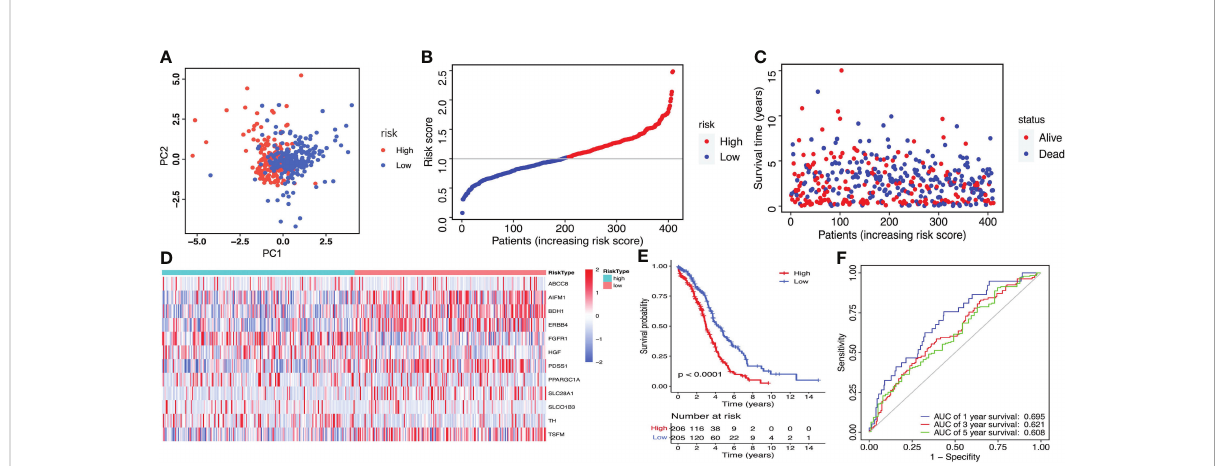
FIGURE 4 Construction of the LMRGs-based prognostic risk signature in the TCGA dataset. (A) PCA was used to determine whether the samples could be grouped correctly based on the prognostic risk signature. (B) The risk score distribution of patients with ovarian cancer. (C) Survival status of patients with ovarian cancer. (D) Heatmap of the 12 LMRGs expression. (E) Survival curves for the low- and high-risk groups. (F) ROC curves analysis of the risk signature on OS at 1 year, 3 years, and 5 years.